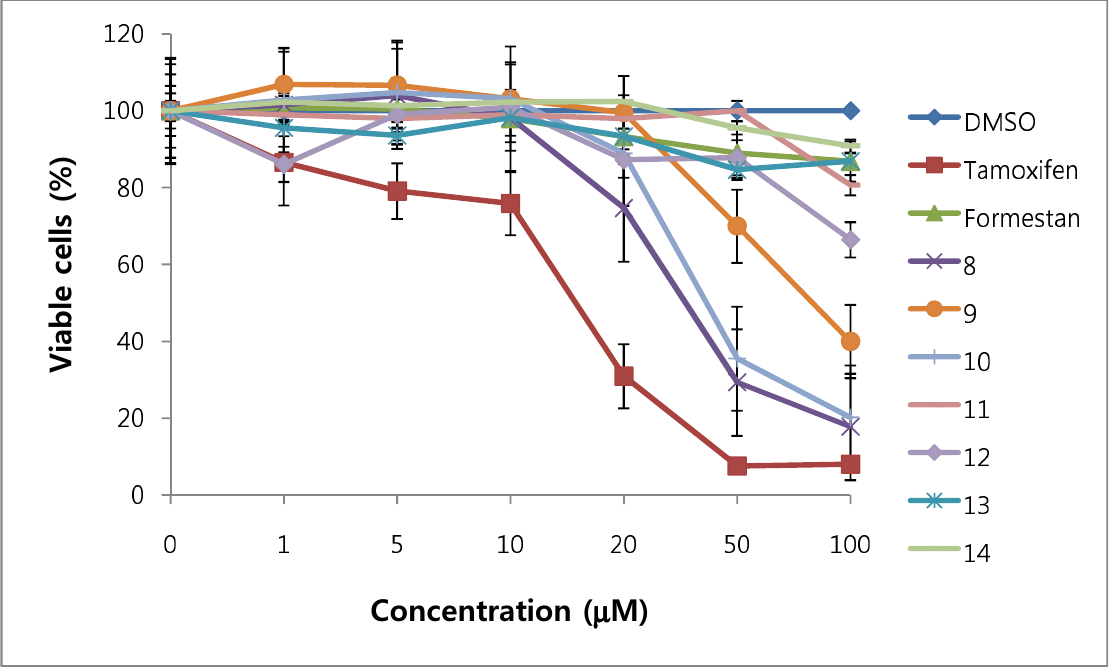
Figure 6. Cytotoxic effects of compounds 8 - 14 in MDA-MB231cells (ER-negative breast cancer